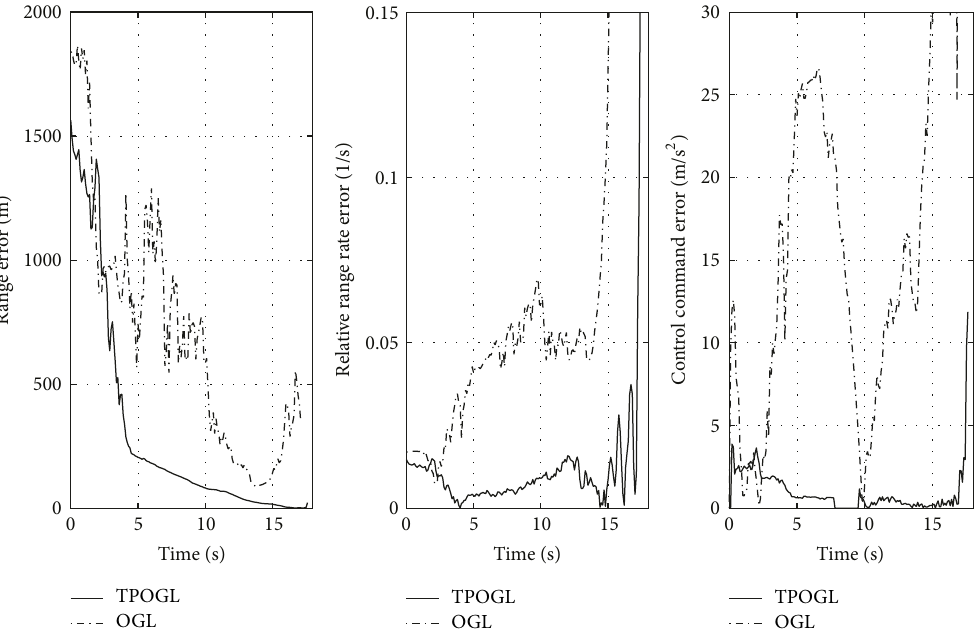
Figure 10: Estimation errors comparisons against maneuvering targets.